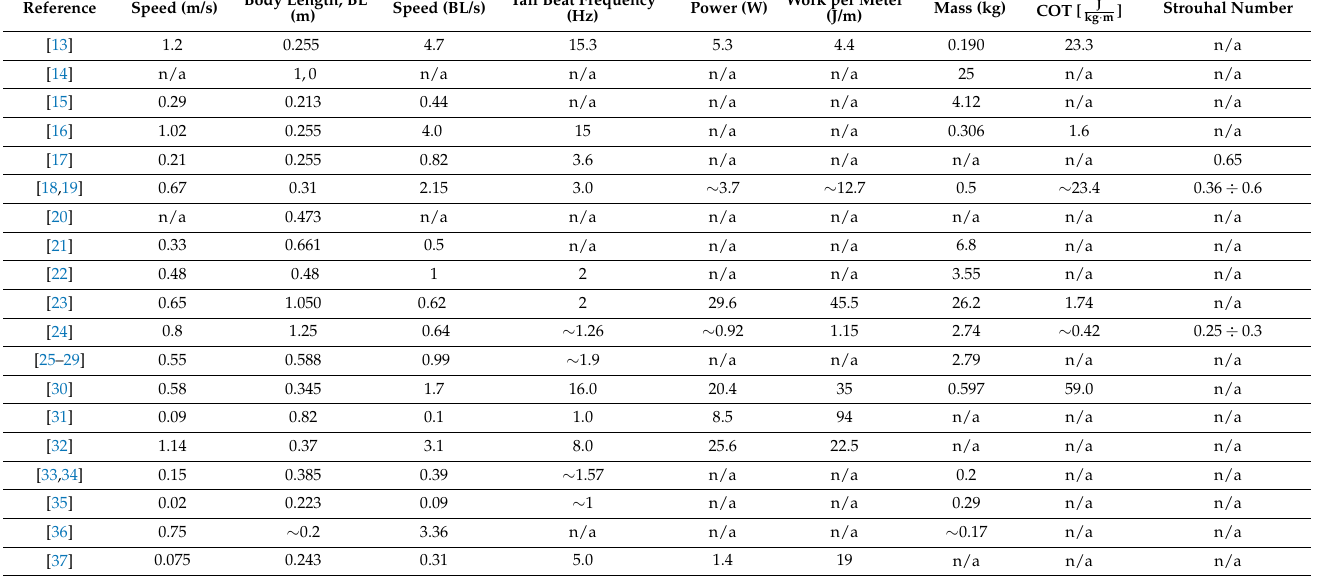
Table 1. Relevant works from the available literature that was considered to frame the context of the present research